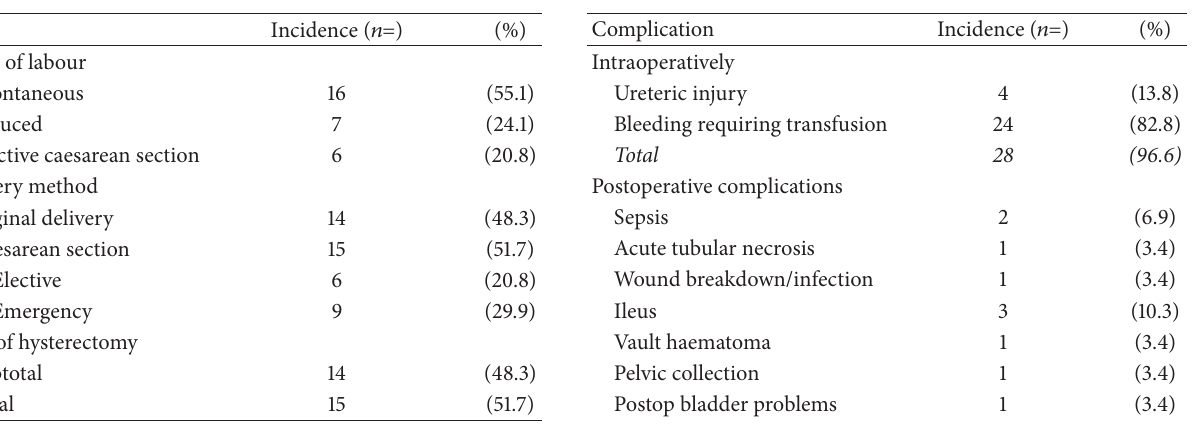
Table 1: Delivery details and type of hysterectomy. Table 2: Intraoperative and postoperative